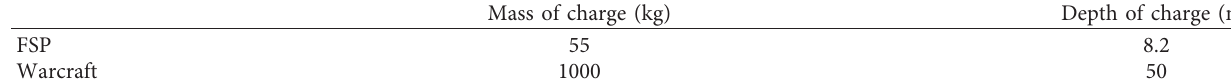
Table 1: The work condition of FSP and warcraft.